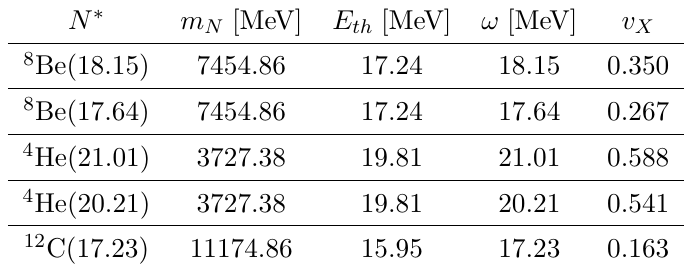
Table 6 . N mass, threshold energy E th , boson energy ω in the CM frame the velocity v X of an hypothetical boson of mass m 17 MeV emitted in the CM frame at the resonance peak X ' ( E = m ) for all the measured N ∗ states. CM N ∗